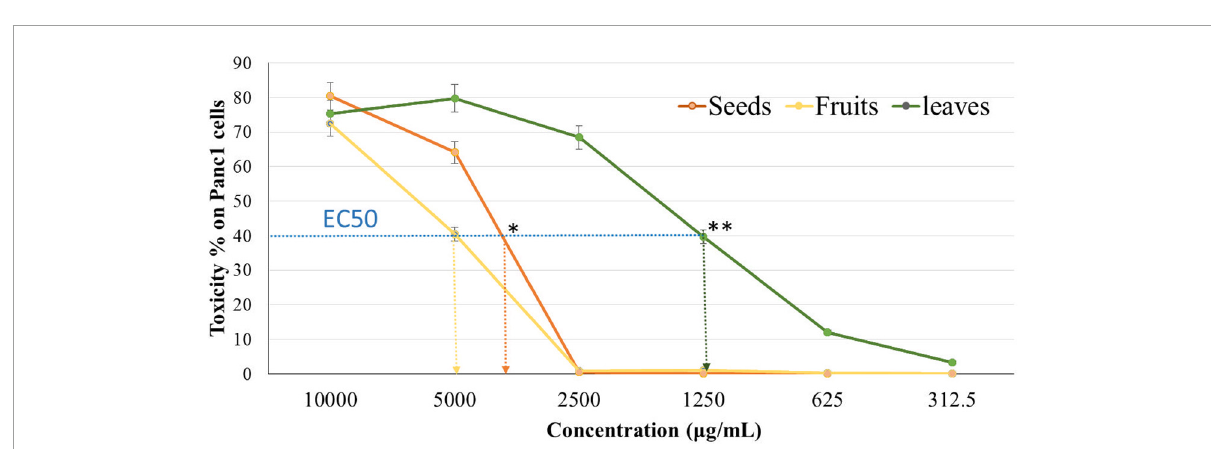
FIGURE4 Cytotoxic effect of leaf, seed, and fruit extract on pancreatic cancer cells (Panc1). * P -value was considered statistically significant ( P < 0.05) and ** P -value was considered highly significant ( P < 0.01).